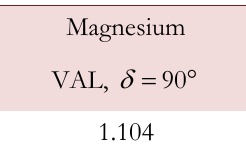
Table 8: Non-proportionality factor used in EESH (Sonsino),